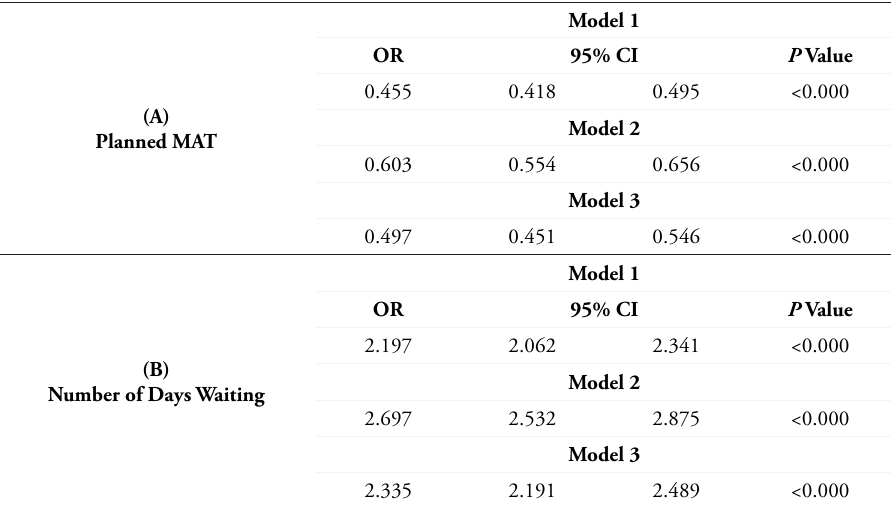
Table 3. Regression Results by Cincinnati CBSA and the United States: (A) Planned Medication- Assisted Opioid Therapy (MAT), (B) Number of Days Waiting to Enter Treatment